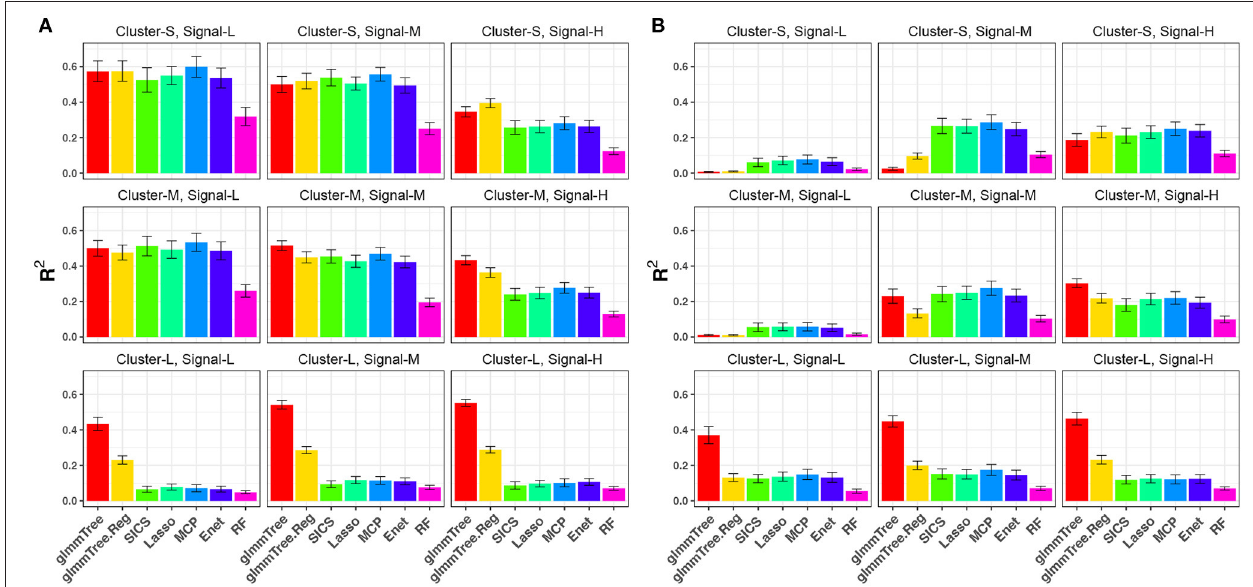
FIGURE 4 | R 2 for binary-outcome simulations across different levels of cluster size and signal density. The abundance of associated OTU clusters is chosen to be high (A) and medium (B) . Cluster-S, -M, and -L represent small, medium and large clusters, and Signal-L, -M, and -H represent low, medium and high signal density,